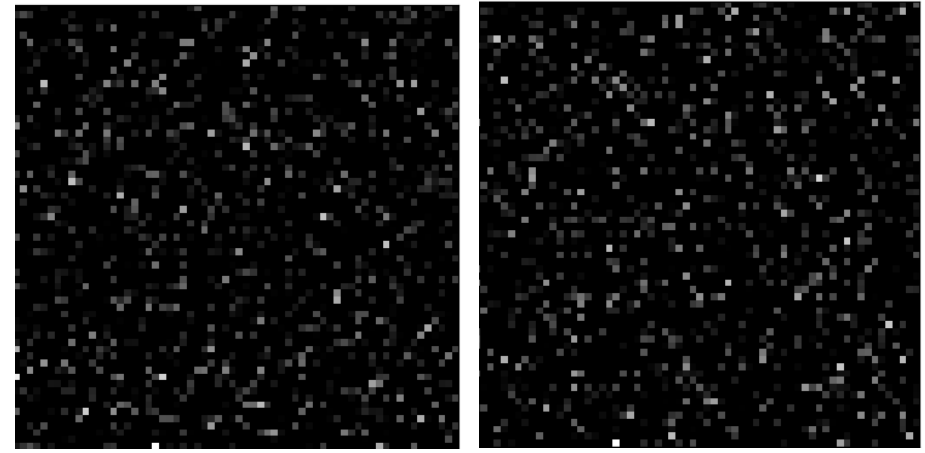
Figure 12. Visualization of the extracted deep features for two